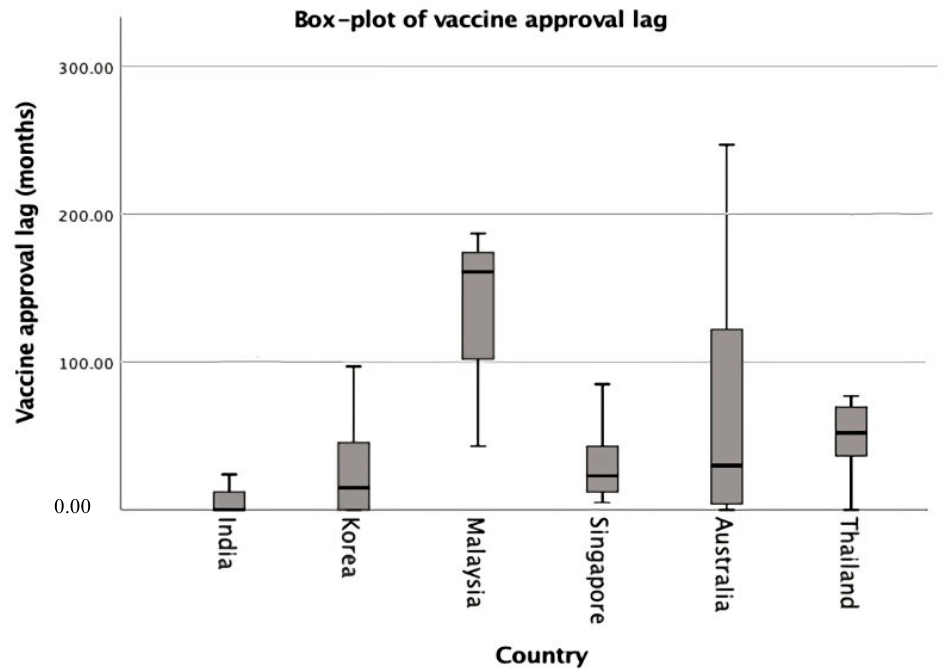
Figure 2. Vaccine relative approval lag .